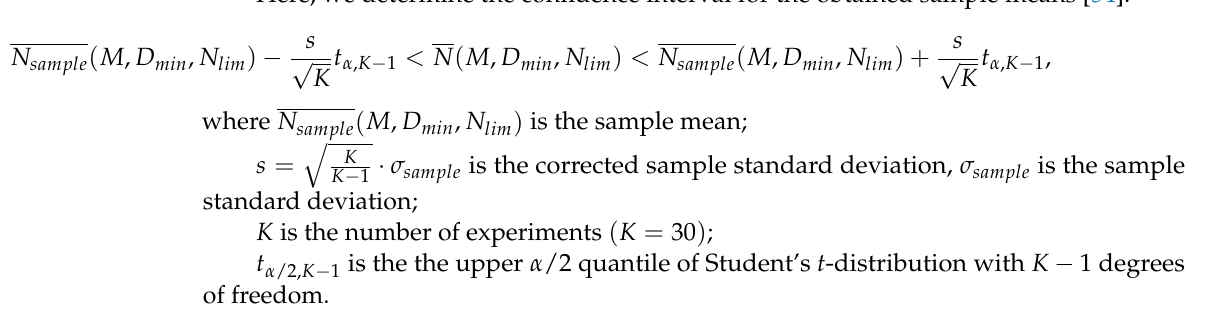
Figure 10. Histograms of the distribution of a random value N ( 11,9, N ( b ) N lim =